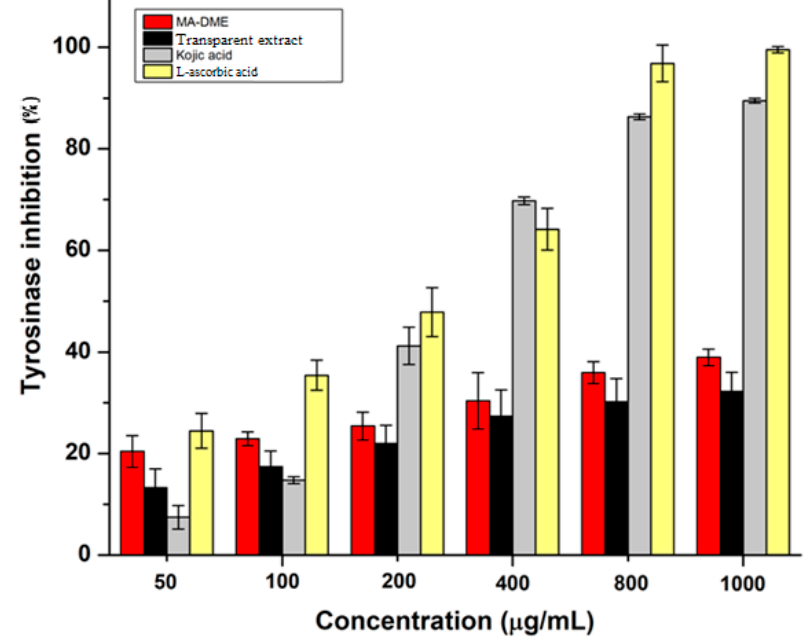
Figure 6. Tyrosinase inhibitory effects of MA-DME, Transparent extract and positive controls, n = 3.